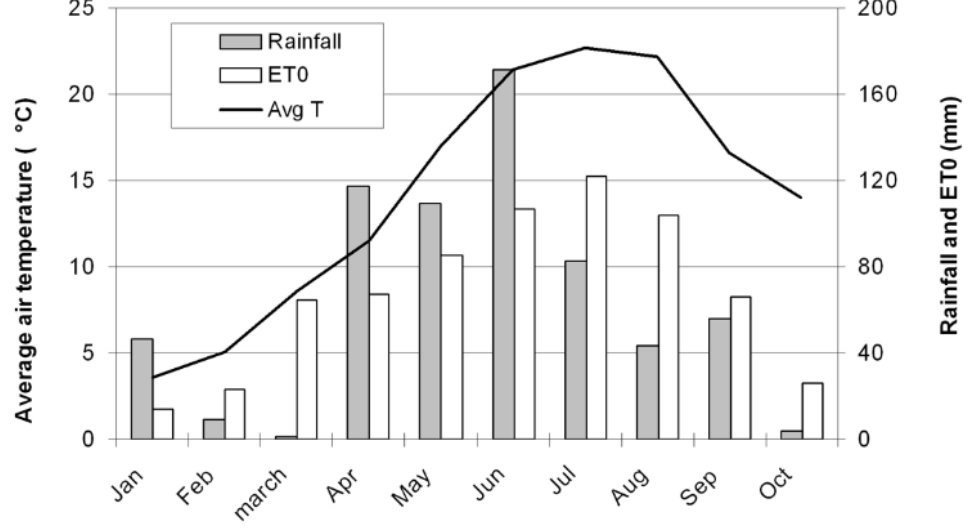
Figure 19. Average temperature, precipitations and evapotranspiration loss during the period